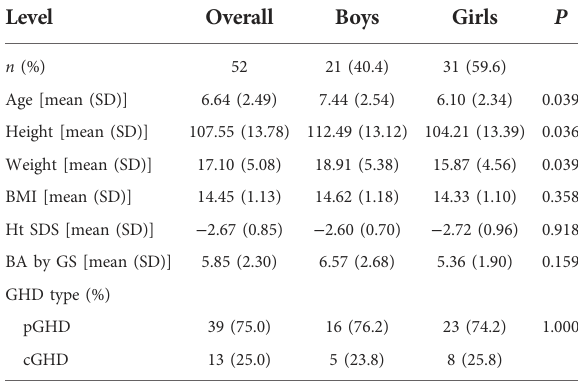
TABLE 1 The demographic characteristics of the 52 GHD patients at the